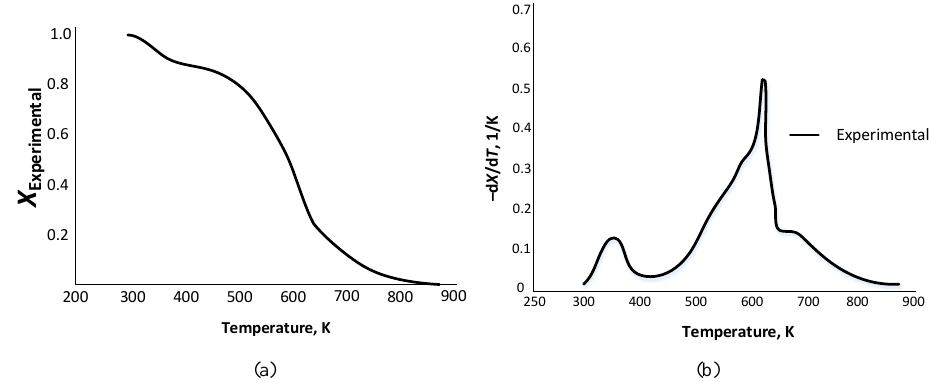
Fig. 2. Experimental TGA (a) and DTG (b) curves for pyrolysis of pine needles at the heating rate of 10